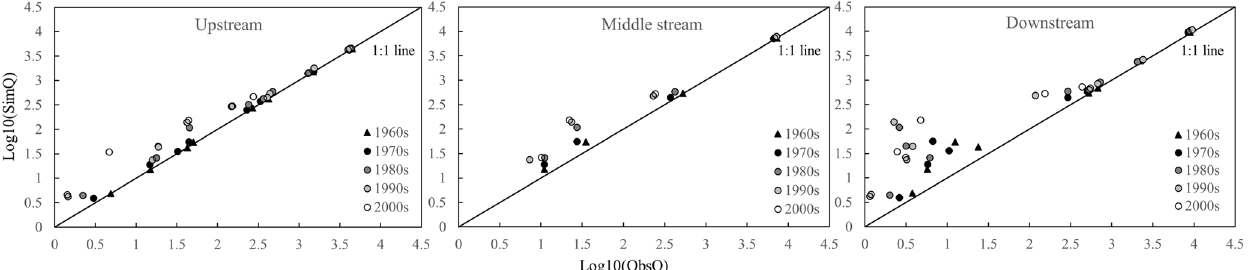
Figure 3. The comparison of observed and natural annual discharge (log 10 transformed) in upper, middle, and lower reaches. Black triangles indicate the 1960s, black dots indicate the 1970s, dark gray dots indicate the 1980s, light gray dots indicate the 1990s, and white dots indicate